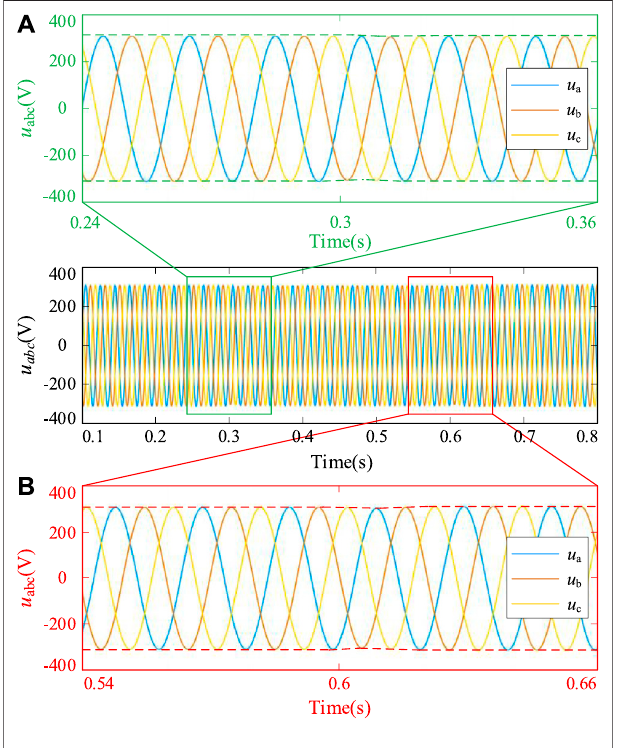
FIGURE 11 | Output voltage of the inverter under the proposed control strategy (three-phase unbalance). (A) Three-phase asymmetric load 1. (B) Three-phase asymmetric load 2.